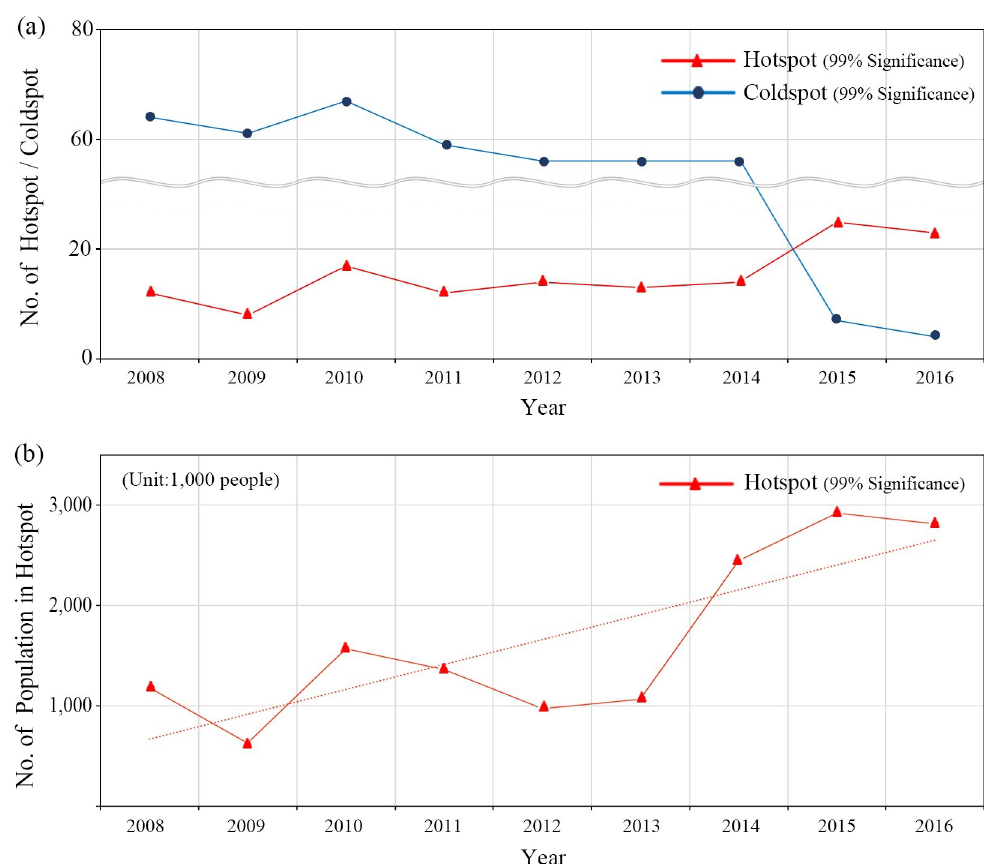
S1 Fig. Plot of eigenvector spatial regression coefficients with 95% confidence intervals.